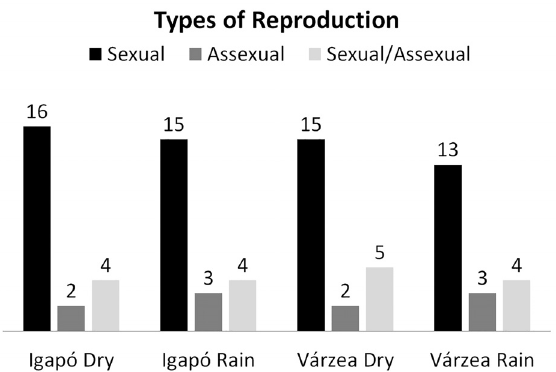
Figure 1 - Number of species and forms of reproduction of bryophytes in the forests of várzea and igapó in periods of drought and